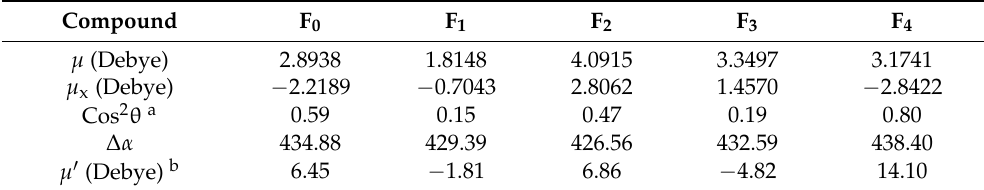
Table 4. The DFT calculated anisotropy ∆ α = [ α XX − ( α YY + α ZZ )/2], dipole moment ( µ ) and molecular dipole moment at long axis ( µ x ) of target compounds.